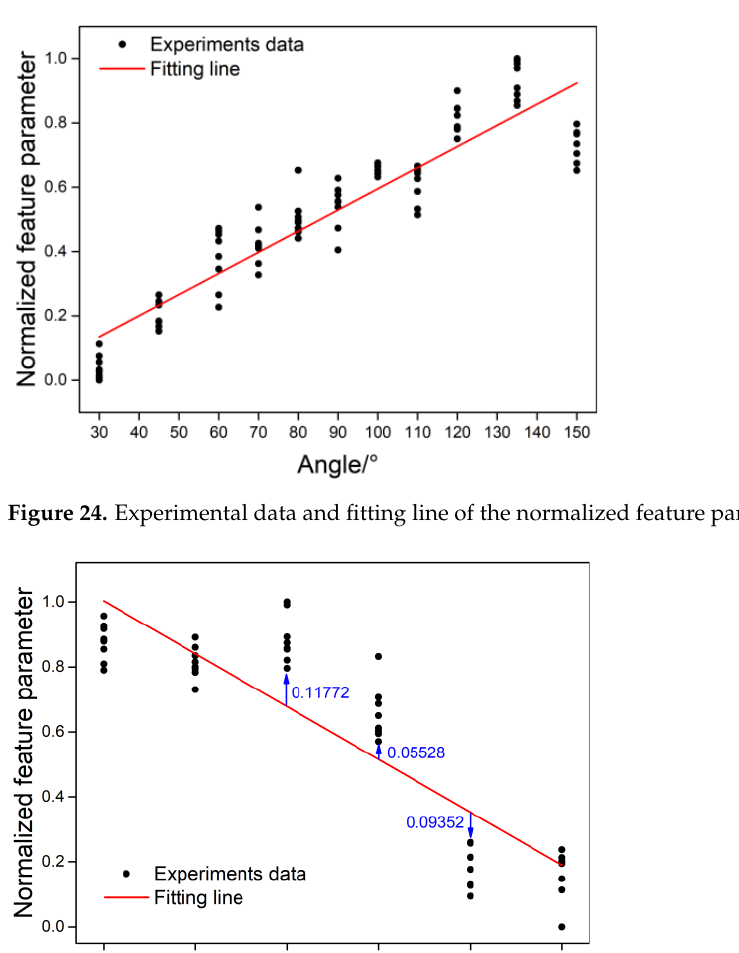
Appl. Sci. 2022 , 12 , 8124 22 of 26 Figure 23. Initial signal and denoising signal of the Tr wave.